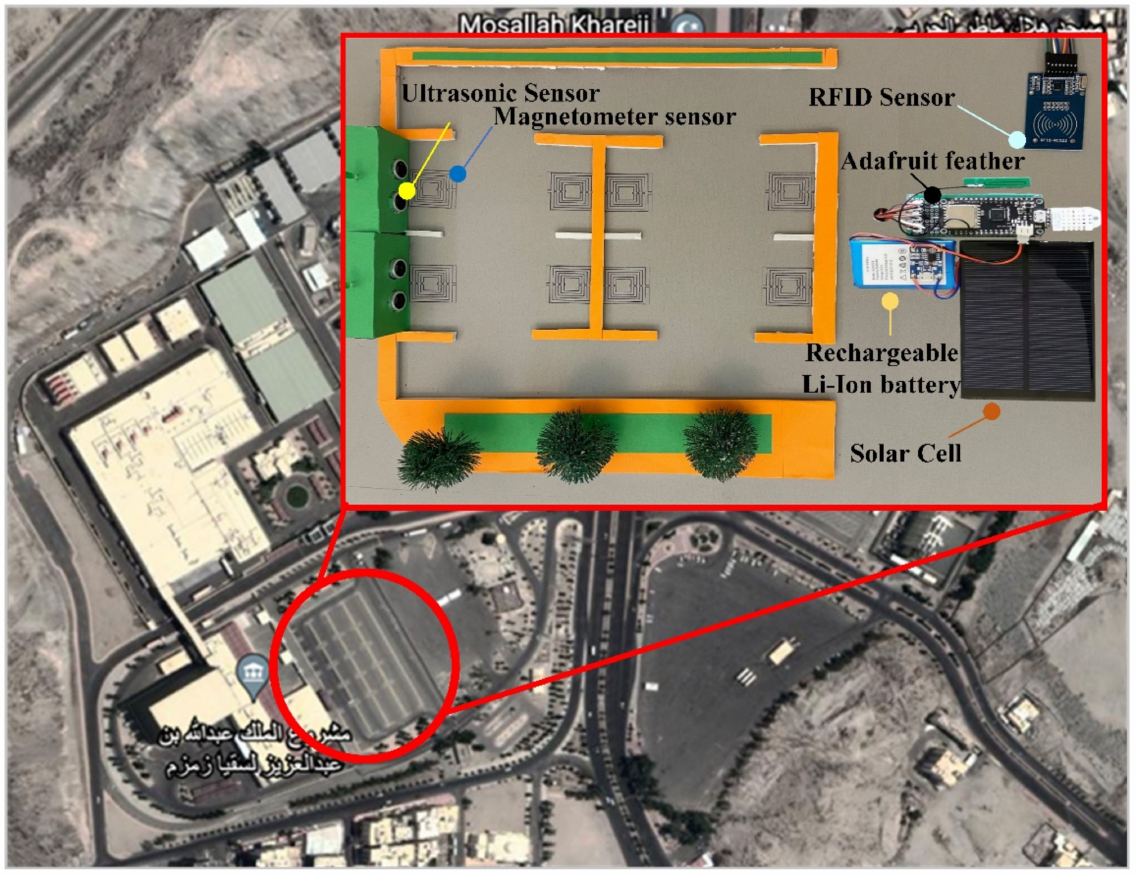
Figure 7. Kudai parking lot and proof-of-concept